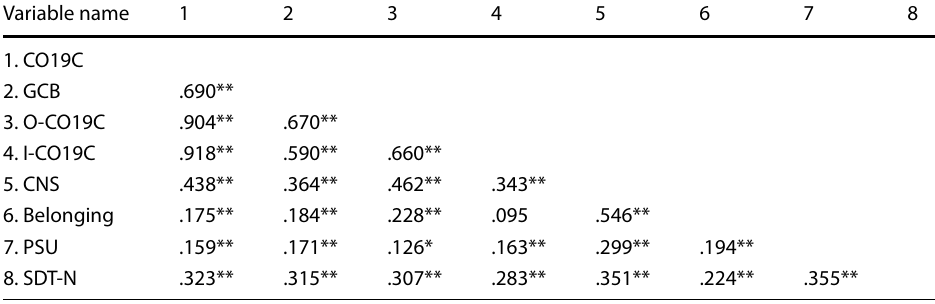
Table 1 Bivariate correlations between